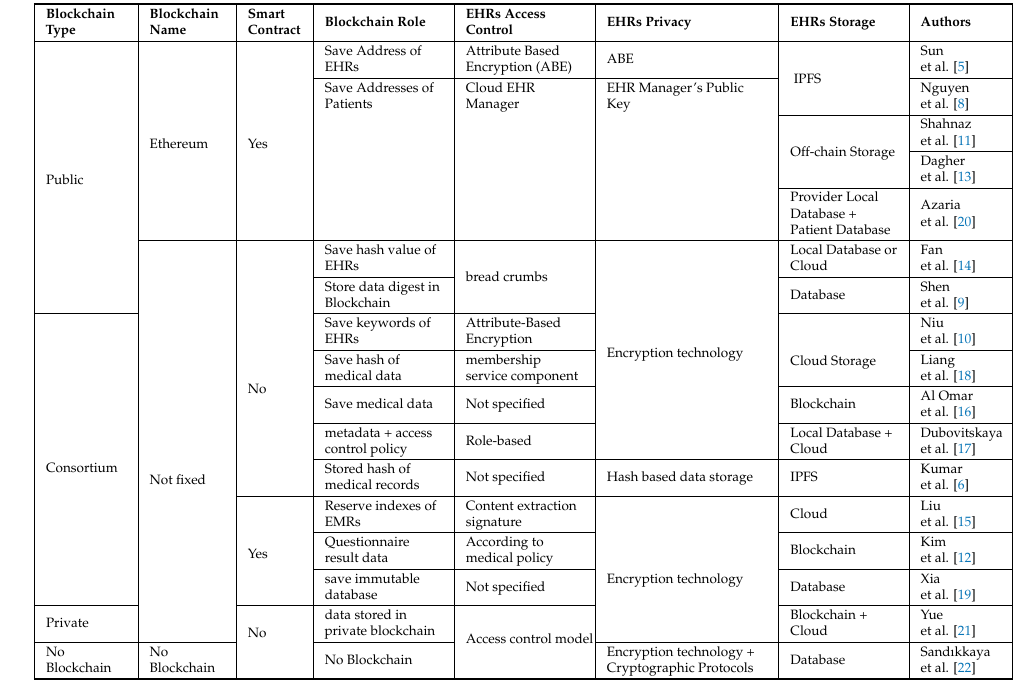
Table 1. Commonalities of related